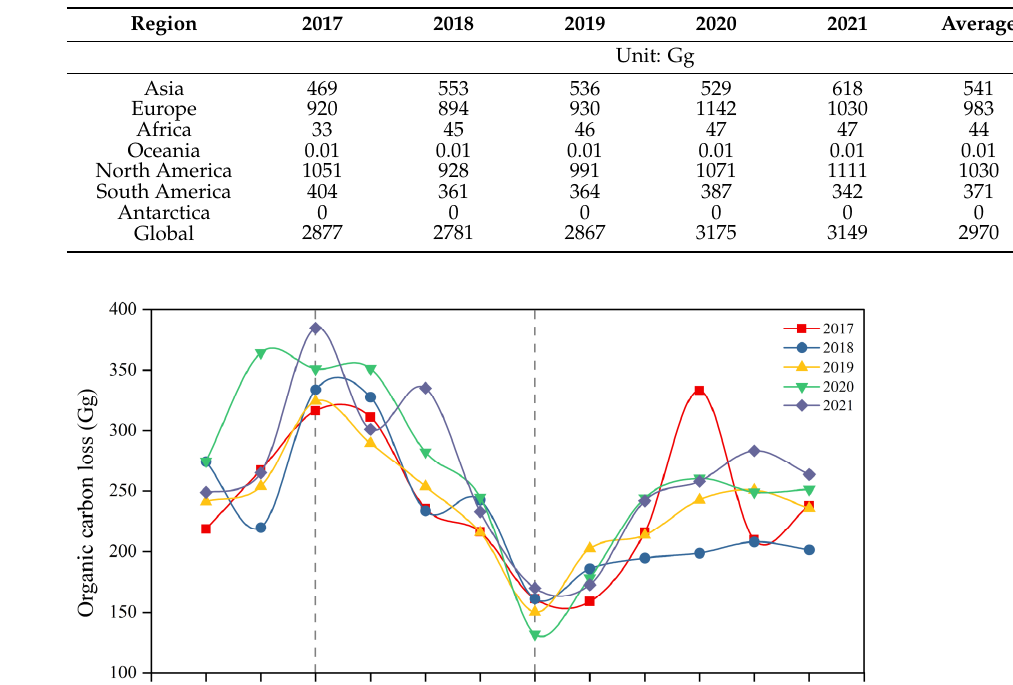
Table 1. Annual loss of farmland organic carbon through wind erosion on different continents, 2017–2021.